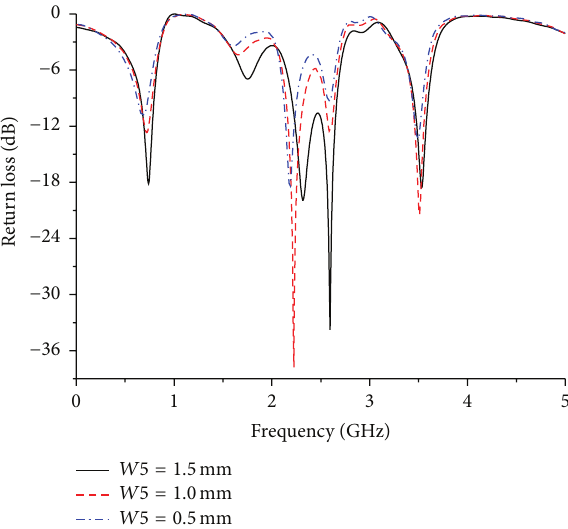
Figure 4: Simulated return loss characteristics for the proposed antenna for various values of 𝐿7 .